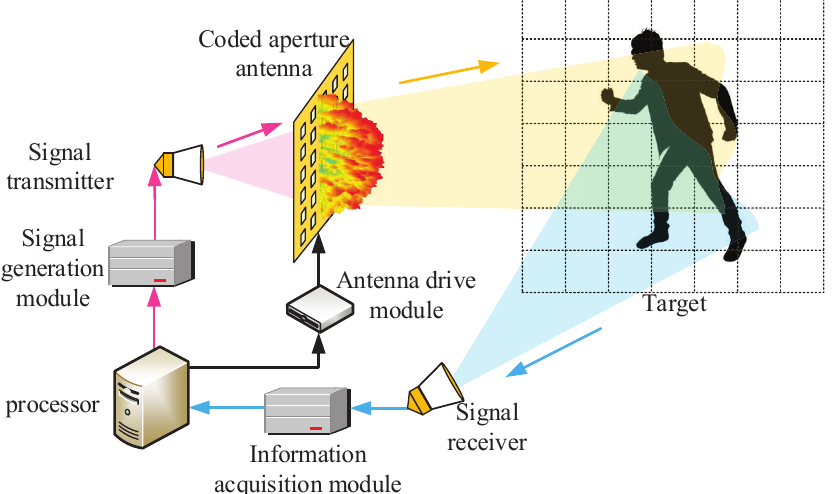
Figure 1. Terahertz coded-aperture imaging